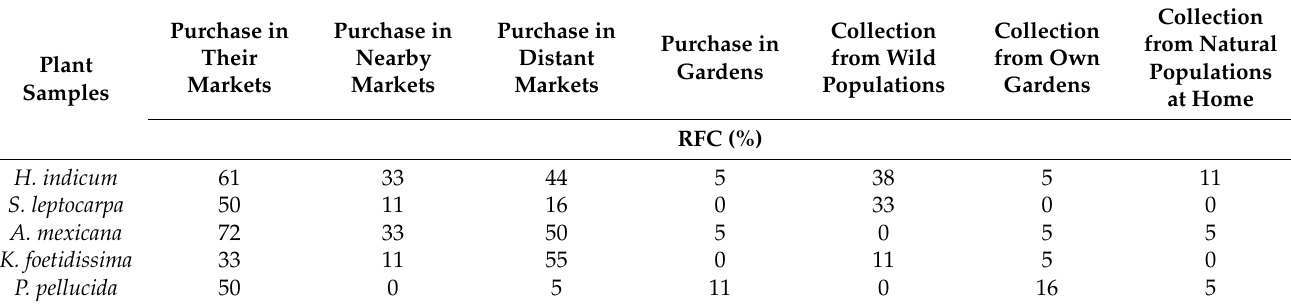
Table 1. Sources of the research species according to traders.